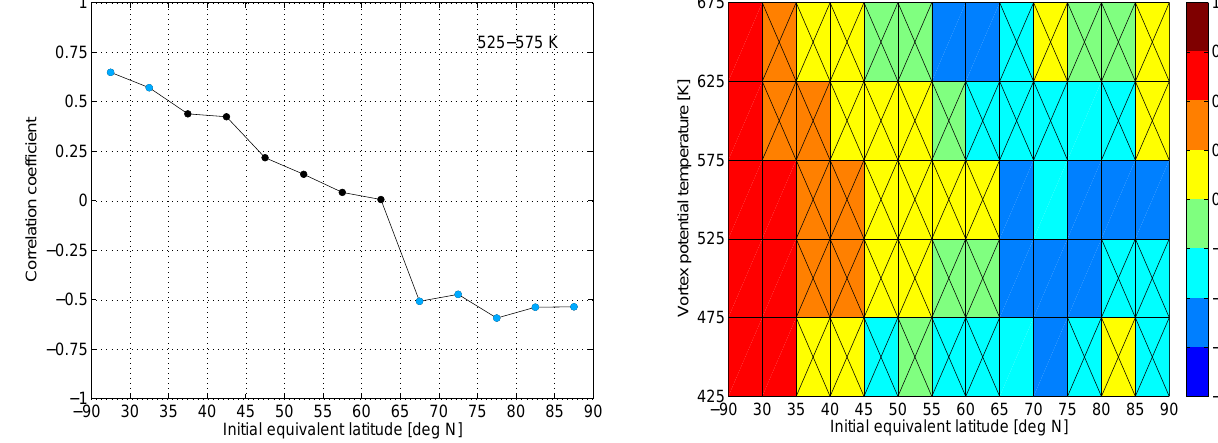
Fig. 13. Correlation of the origin of air inside the polar vortex and EP flux through mid latitudes in autumn. Correlation of a time se- ries (1992–2009) of the vertical component of the EP flux through a pressure level equivalent to 525–575K averaged over 45–75 ◦ N and from September to November and a time series of the frac- tion of air in the vortex in early winter at 525–575K originating from the equivalent latitude intervals given at the horizontal axis on 1 September. Correlation coefficients significant at the 95% level are shown in blue. Time series are detrended.